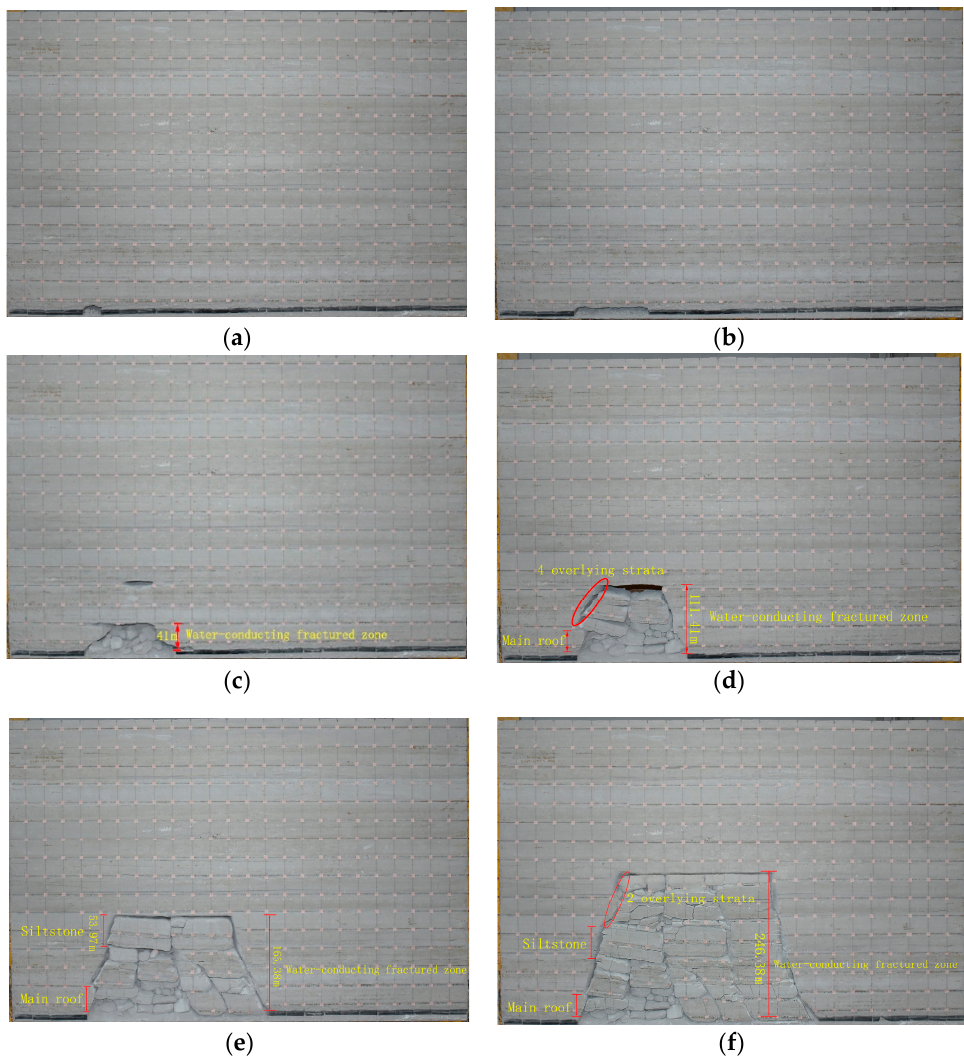
Figure 8. Overburden fracture characteristics: ( a ) rock mass failure as the working face moved for-